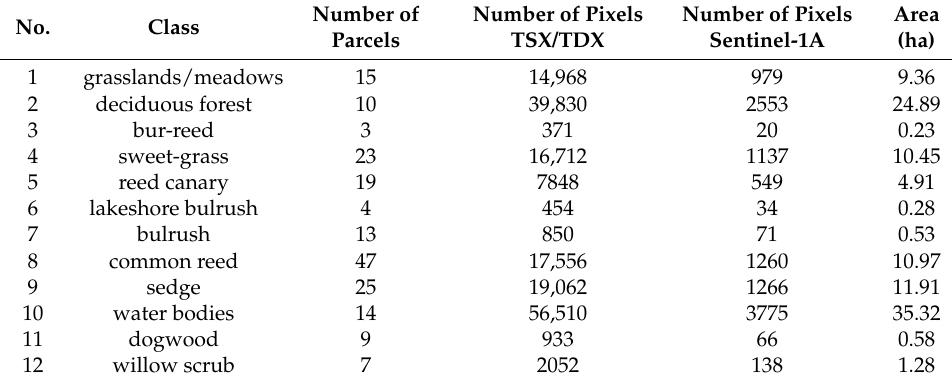
Table 1. List of the vegetation types recognized in the Area of Interest, the number of parcels, the number of pixels and their area.